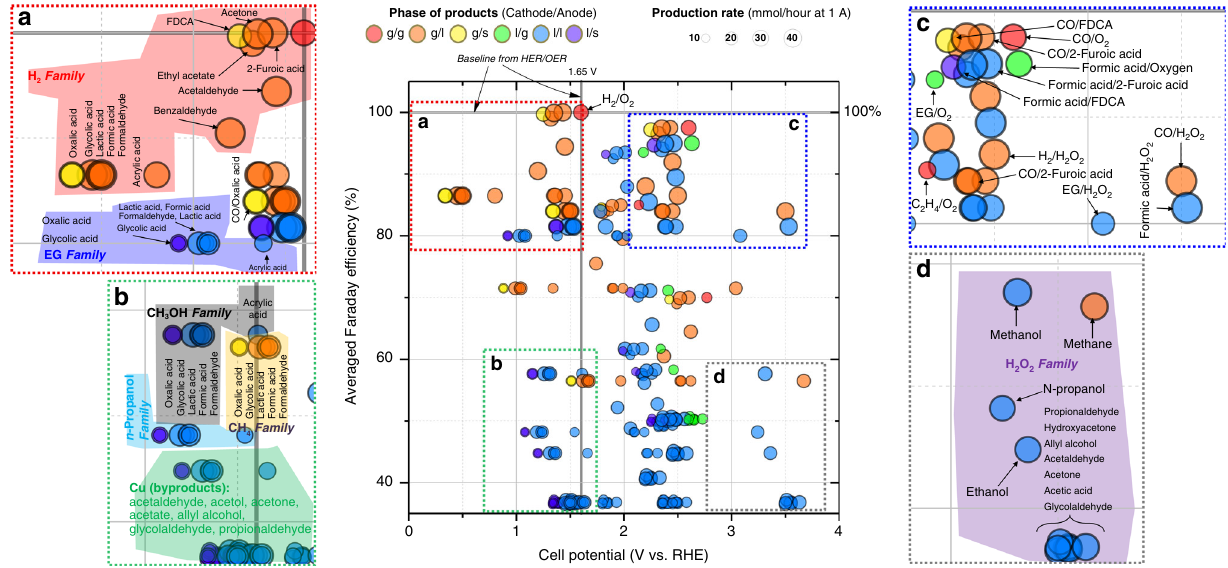
Fig. 2 Faraday ef fi ciency vs. cell potential for e -chemical paired electrolysis. a High FE and low cell potential. b Low FE and low cell potential. c High FE and high cell potential. d Low FE and high cell potential. Some OOR FE data were missing; the lowest value was assumed, 73% for lactic acid from glycerol Table 1 The typical characteristics of the main redox reactions in the paired electrolysis system Product